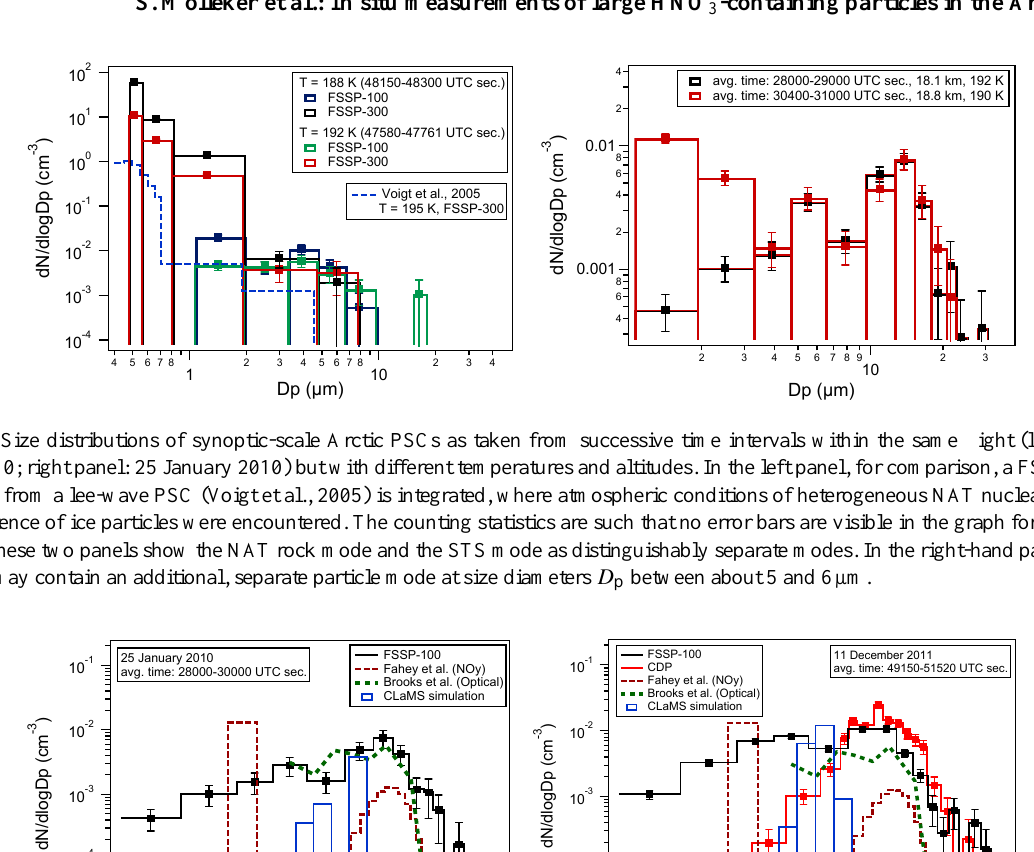
diameters close to the mode maximum at 12 to 15 µm